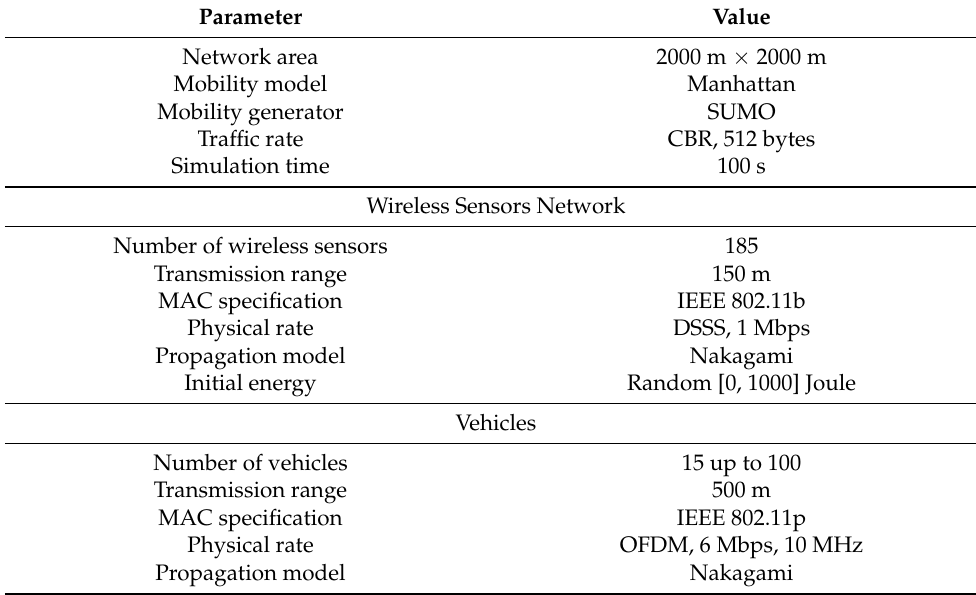
Table 1. Simulation settings in urban